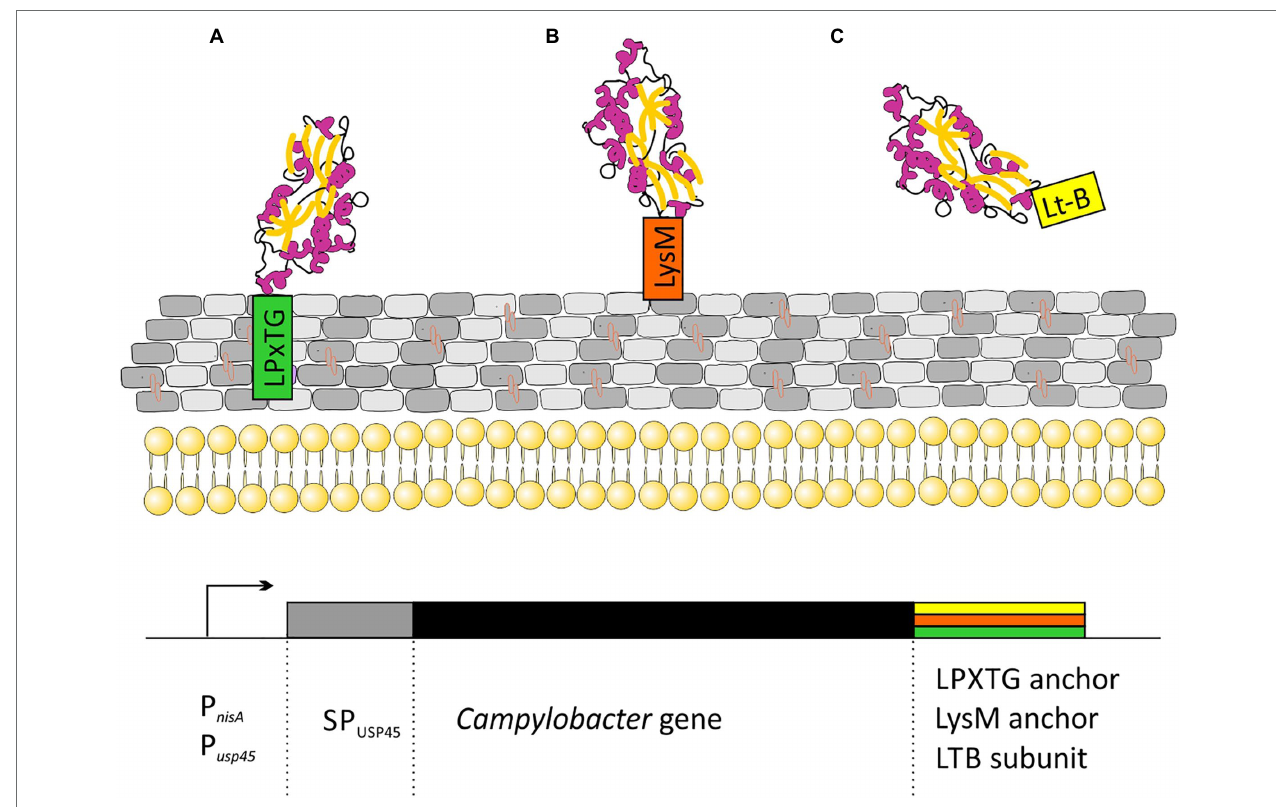
FIGURE 3 | Schematic representation of strategies for the cloning of C. jejuni genes for secretory expression in Lactococcus lactis: (A) Campylobacter protein covalently attached to peptidoglycan via the CWA domain from M6 or YndF proteins; (B) Campylobacter protein non-covalently attached to peptidoglycan via LysM domains from AcmA protein; and (C) secreted Campylobacter protein fused to labile enterotoxin subunit B domain. Transcription of the cloned genes is driven by an nisin-inducible P nisA promoter or strong, constitutive P usp45 promoter. SP usp45 – signal peptide of Usp45, the major Sec-dependent protein secreted by L. lactis